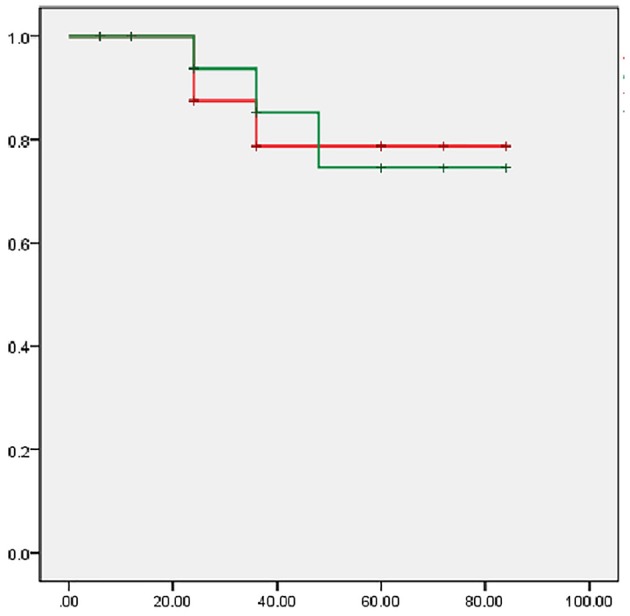
Kaplan–Meier analysis of cumulative primary and secondary patency rates. X-axis: follow-up time (month); Y-axis: patency rates; Red line: cumulative primary patency rate; Green line: cumulative second patency rate.